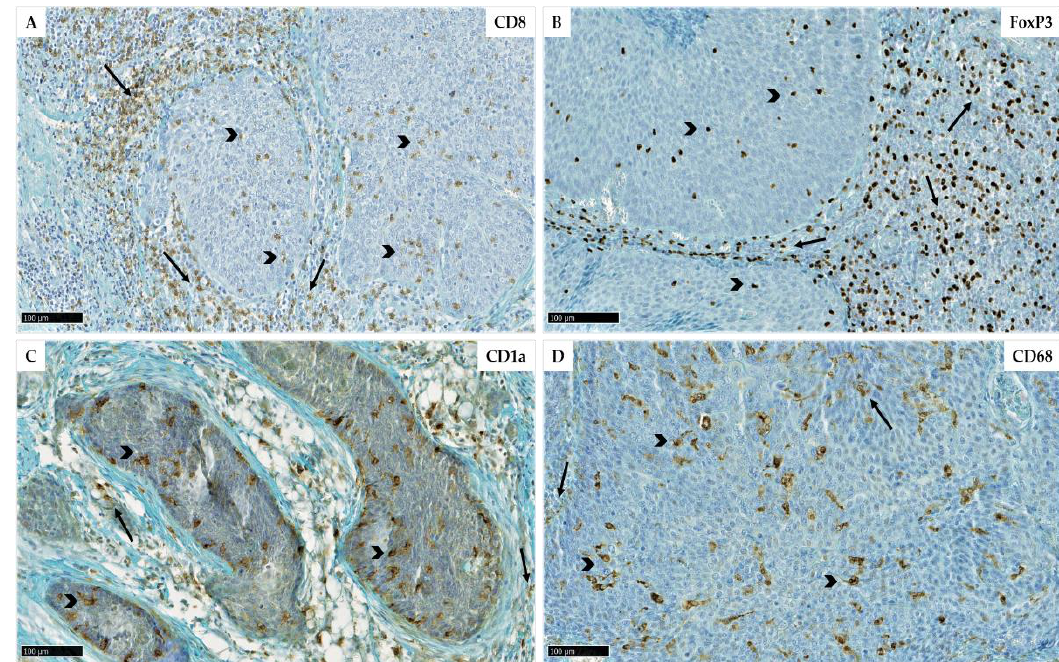
Figure 1. Immunohistochemical representation of CD8 ( A ), FoxP3 ( B ), CD1a ( C ) and CD68 ( D ) ex- pression (scales = 100 µm) in stromal (arrows) and intratumoral (arrowheads) areas of oropharyngeal carcinomas. Bars = 100 µm. Table 2. Descriptive table of immune cell density according to different subgroups including p16- negative, -positive, low-stage and high-stage